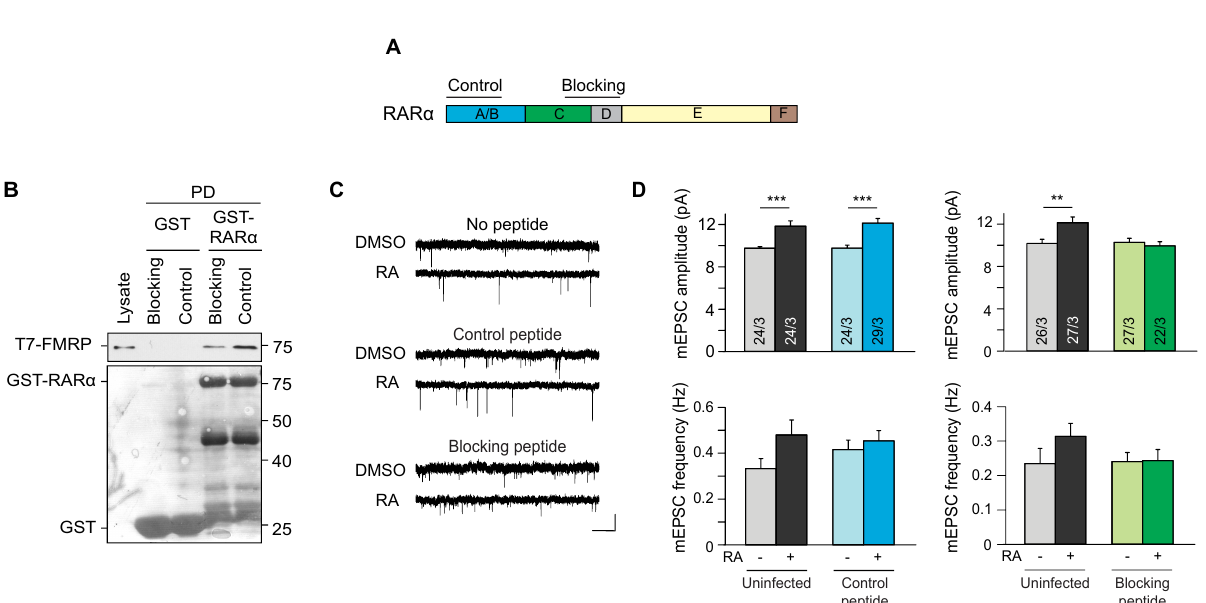
Figure 5. Blocking interaction between FMRP and RAR α abolishes RA-induced synaptic plasticity. ( A ) A schematic drawing showing the locations of the blocking peptide and the control peptide mapped to RAR α . ( B ) Pull-down of T7-FMRP with GST-RAR α in the presence of purified control or blocking peptide. ( C ) Representative traces of miniature EPSCs recorded from CA1 pyramidal neurons of hippocampal slice cultures infected with lentivirus expressing either the GFP-tagged control or blocking peptide and treated with RA. Scale bars, 10 pA, 1 s. ( D ) Quantification of miniature EPSC amplitude and frequency after a 4 h treatment with DMSO or 10 µ M RA (** p < 0.01; *** p < 0.001; Mann-Whitney). All graphs represent average values ±